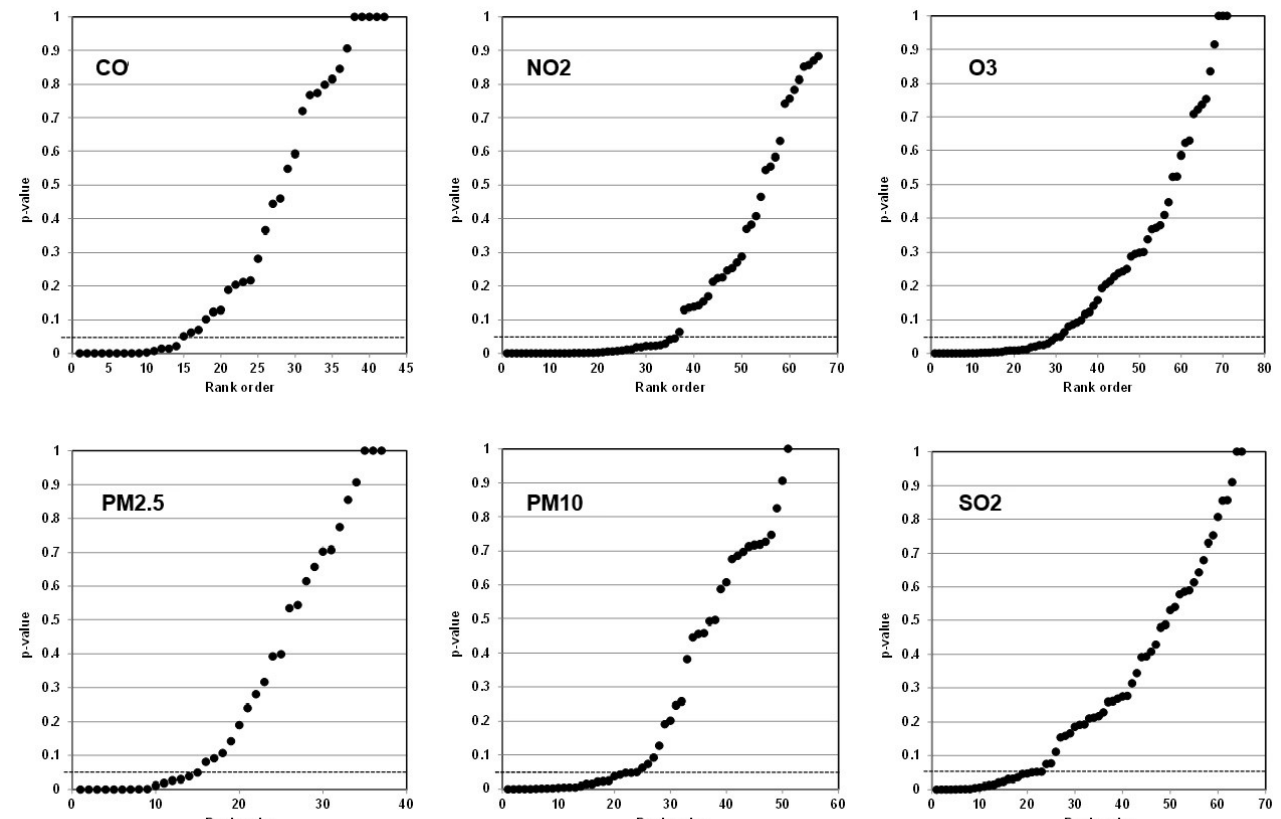
Figure 2. p -Value plots for six air quality components of the Zheng et al. meta-analysis.